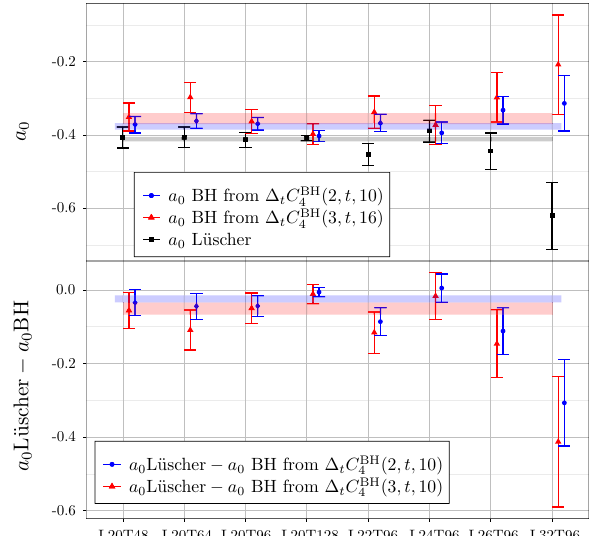
Fig. 3 Comparison of a 0 computed with BH method Eq. (4) with t i = 2 and t f = 10 (blue circles), with t i = 3 and t f = 16 (red triangles) and Lüscher method Eq. (5) (black squares) in the top panel. In the bottom panel we plot the correlated difference between Lüscher method and BH method. The horizontal bands correspond to the weighted average of each